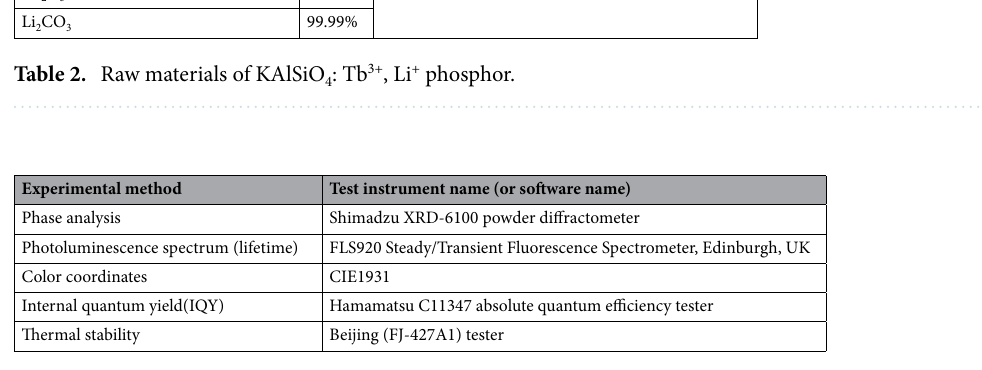
Table 3. Instrument parameters and experimental methods used in this study.